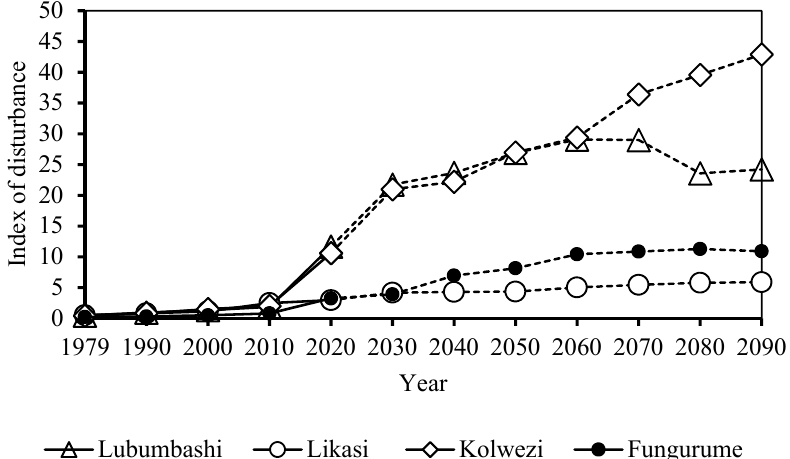
Figure 5. Evolution of the disturbance index in the 4 zones of Southeastern Katanga (Lubumbashi, Likasi, Fungurume and Kolwezi) between 1979 and 2090.